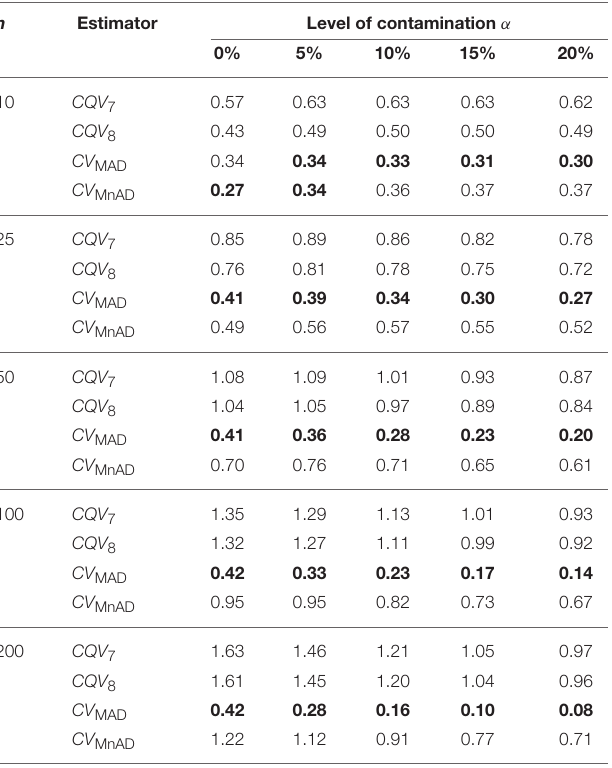
TABLE 3 | Median values of log 10 ( γ ) accuracy metric across θ produced for each estimator and sample sizes under the scaled-contaminated normal distribution CN ( µ , σ , α , λ ).